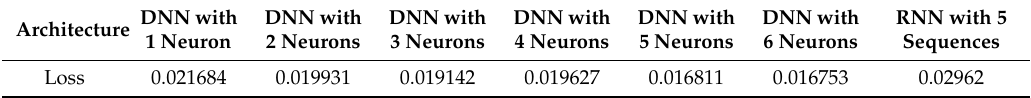
Figure 10. Loss of RNN. Table 2. Average loss rate of each of the Table 2. Average loss rate of each of the architectures.